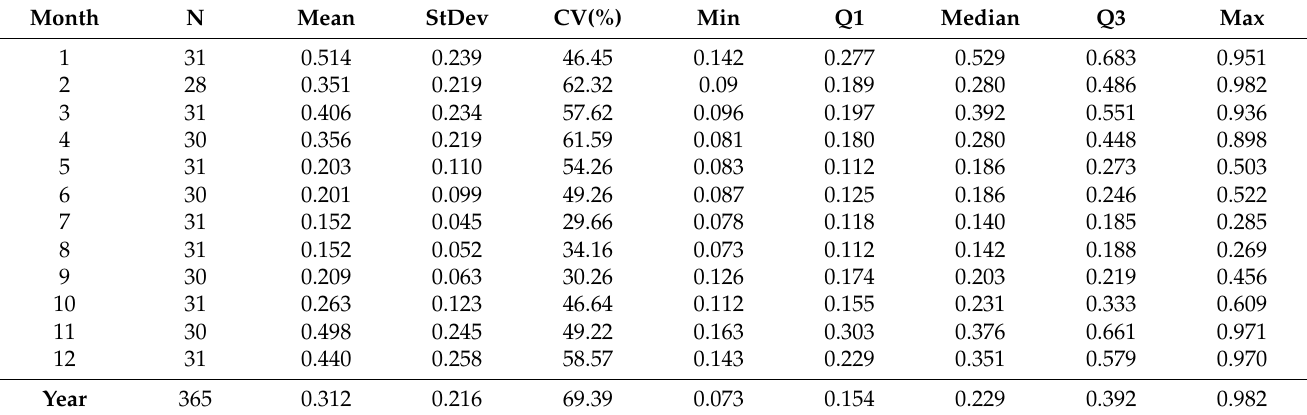
Table 11. Descriptive statistics of the daily fraction of diffuse to global radiation ( K D